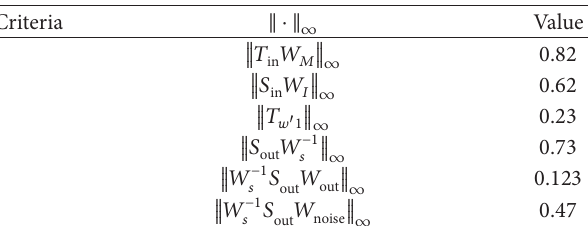
Figure 15: Output of the controller 𝐾(𝑠) with disturbance attenua- tion. Table 9: Value of robust